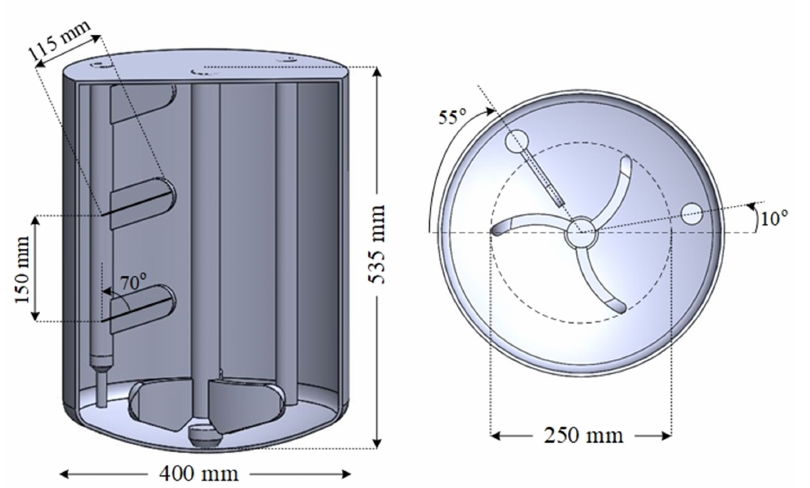
Figure 2. Geometry of the pilot-scale